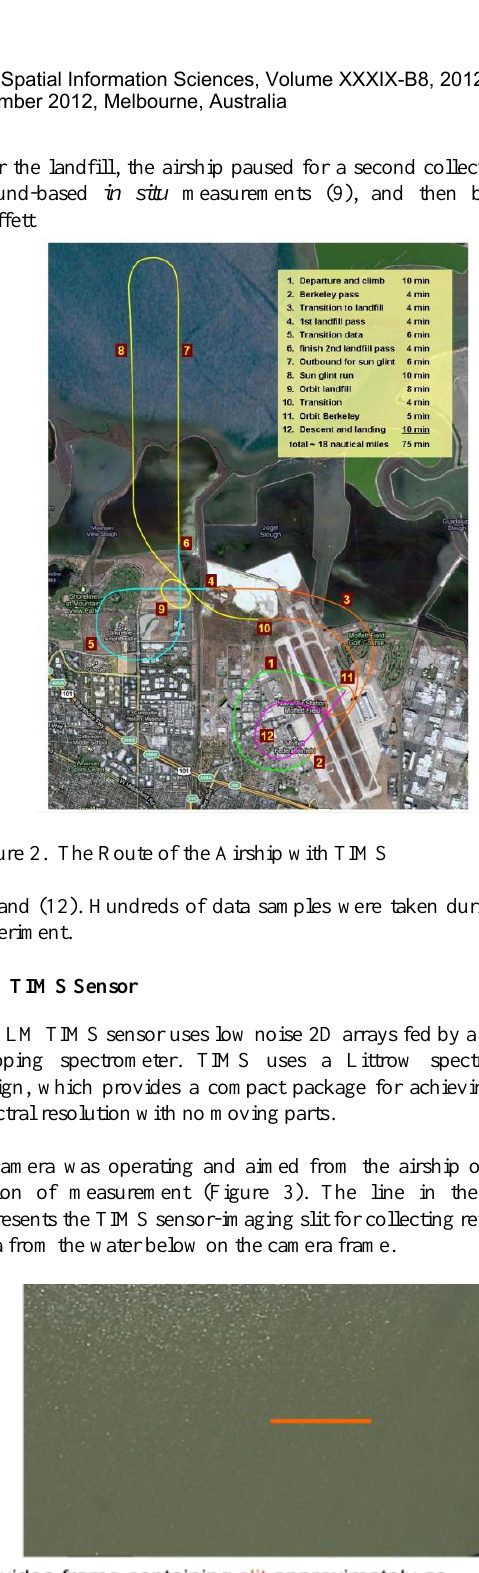
Figure 3. Camera image from the Airship over region of no sunglint. Linear line is the TIMS sensors imaging